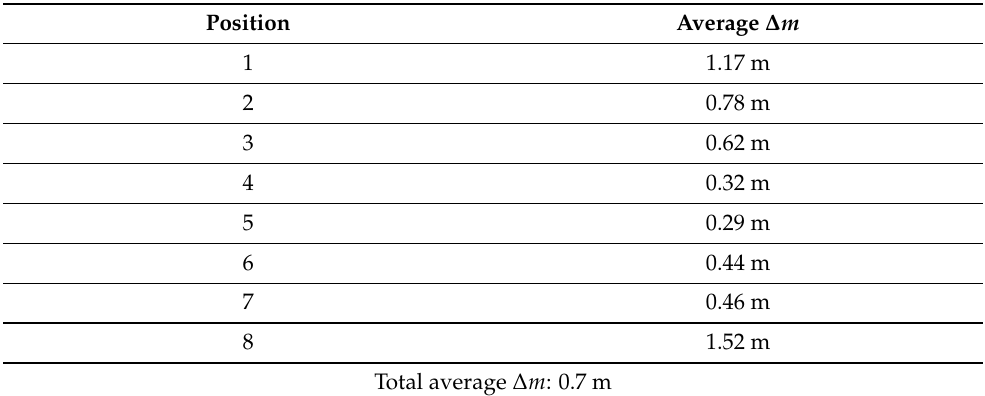
Table 2. Error regarding average